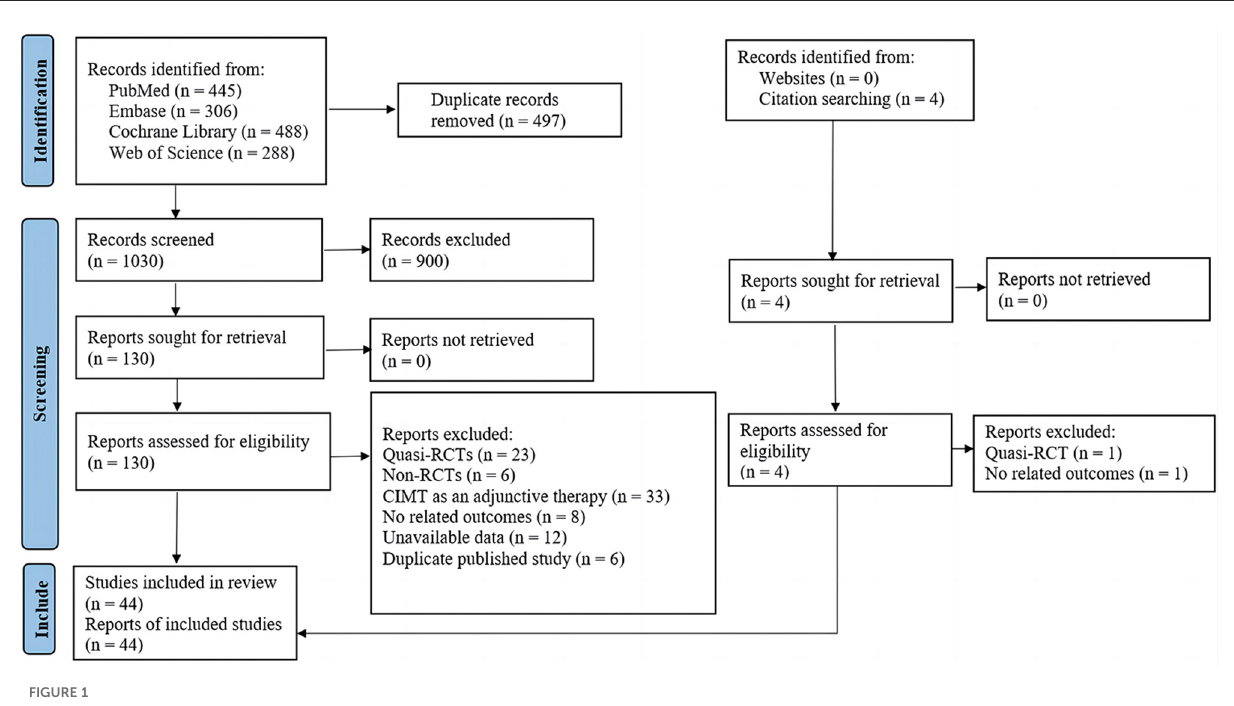
FIGURE1 PRISMA flowchart.